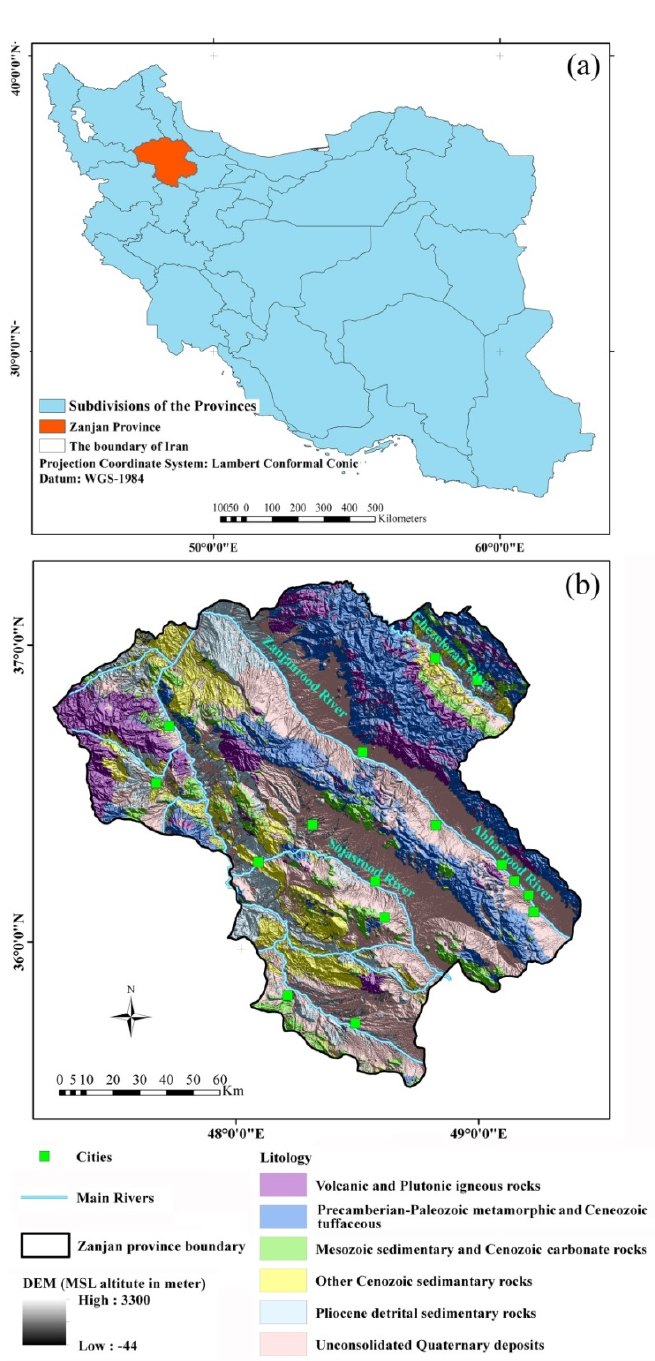
Figure 1. The case study area. ( a ) Iran boundary and related political boundaries and provinces, ( b ) Zanjan province and its topographic and lithological structure.